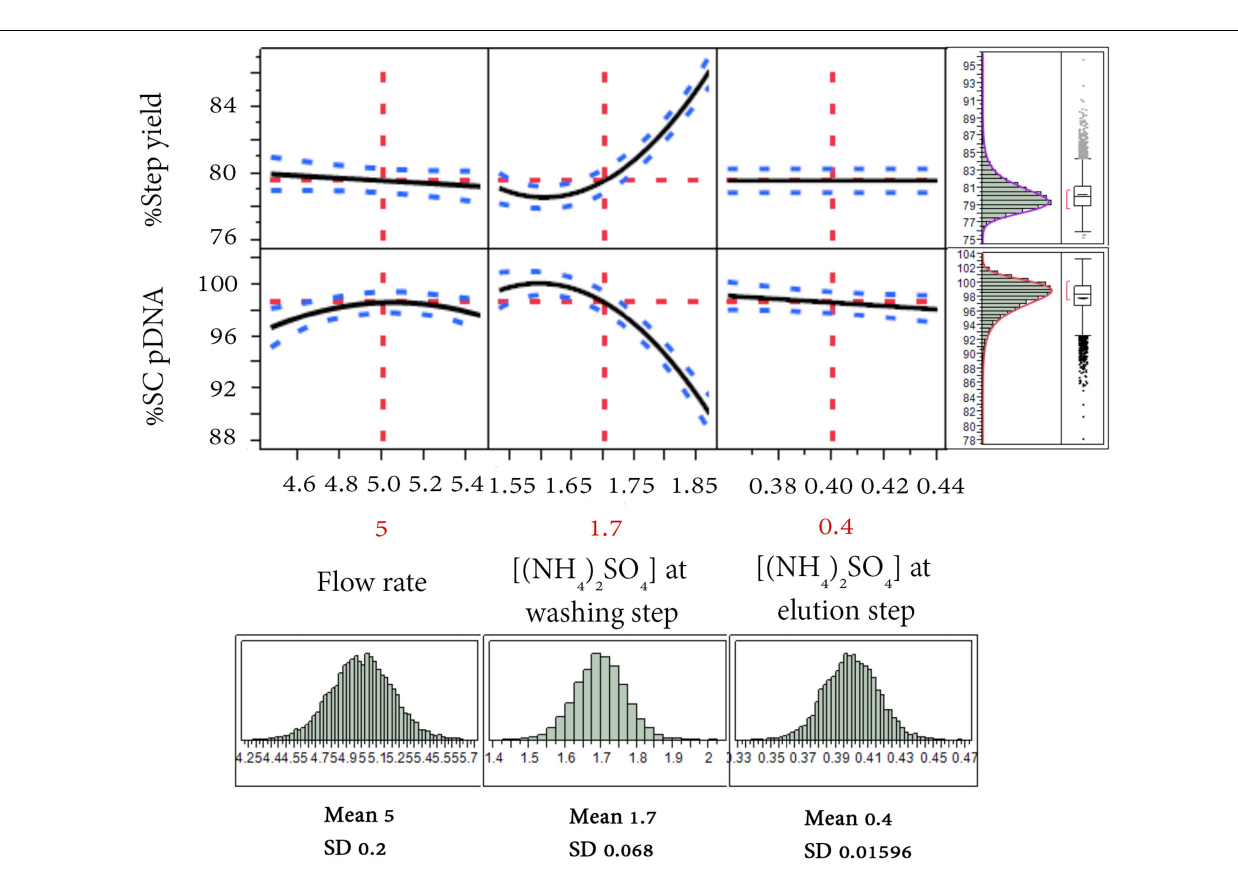
Frontiers in Bioengineering and Biotechnology |